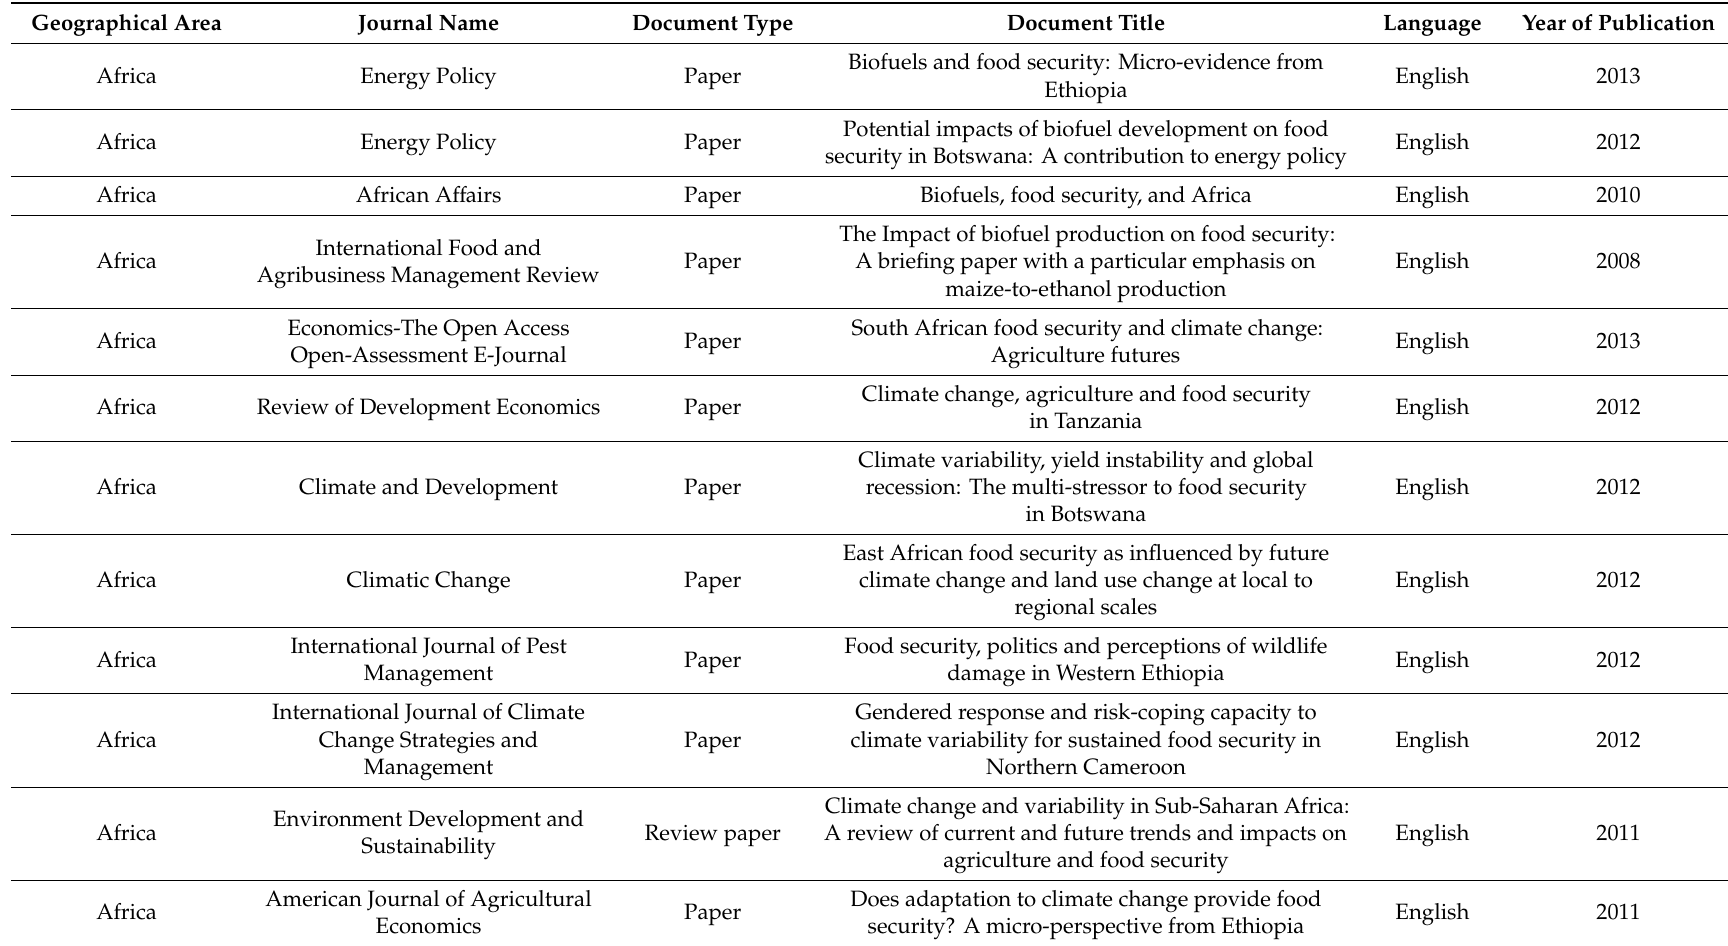
Table A1. Documents discarded in the literature review and not listed in the reference